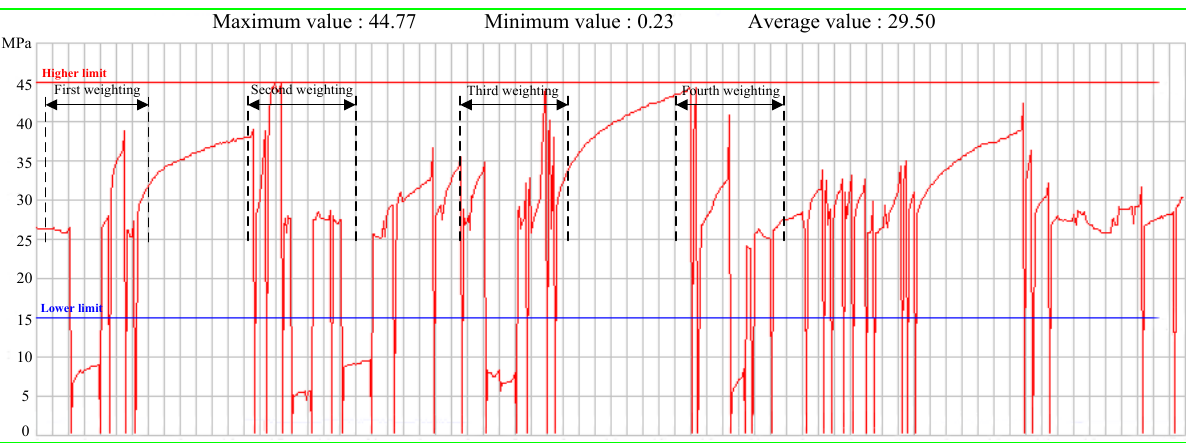
Figure 19. The working resistance of hydraulic supports during the periodic